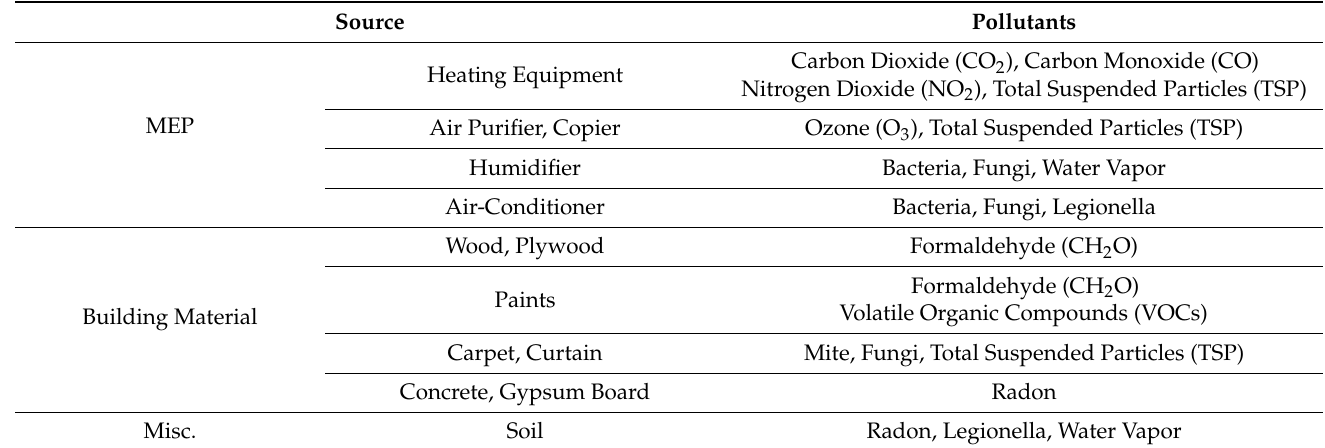
Table 2. Hazardous substances source and